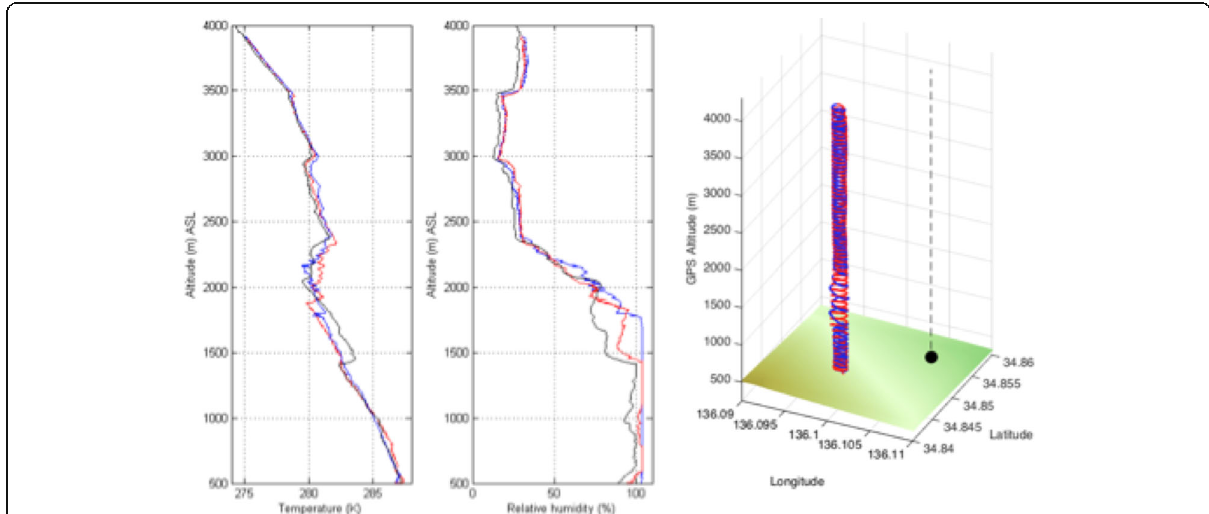
Fig. 23 ( Left panel ) Vertical profiles of temperature and relative humidity from the Vaisala sonde ( black curves ) and the UAV-borne iMET sonde ( red curves ascent, blue curves descent) for UAV 4. ( Right panel ) The trajectory of UAV 4 ( red ascent, blue descent). The Vaisala sonde was launched from the MU radar site (indicated by the black circle ) 15 min after the UAV was launched and ascended at a nominal rate of about 2 ms −